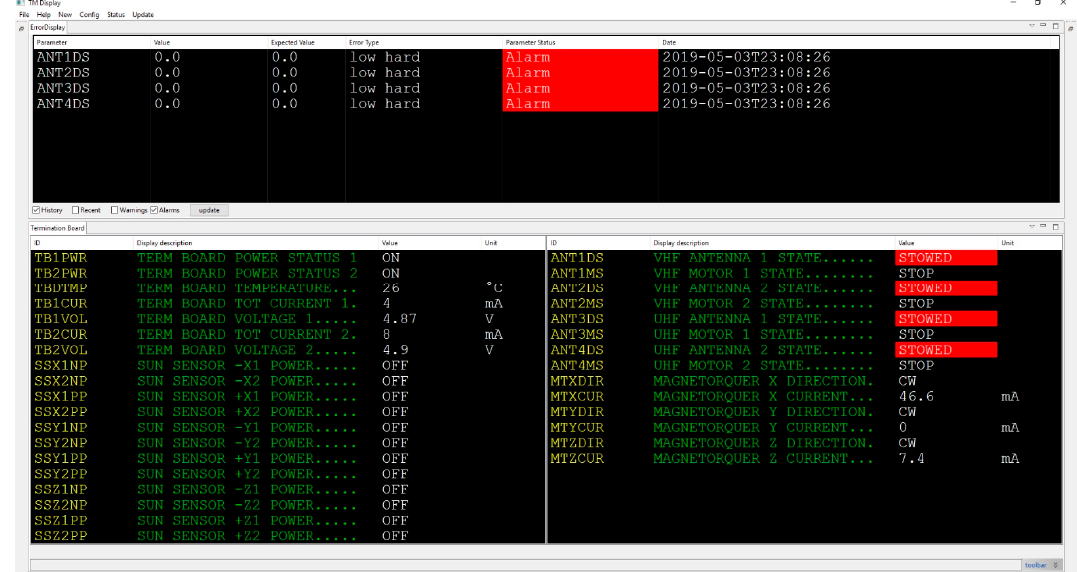
Figure 2. Telemetry client displaying a telemetry page of housekeeping data with violated threshold